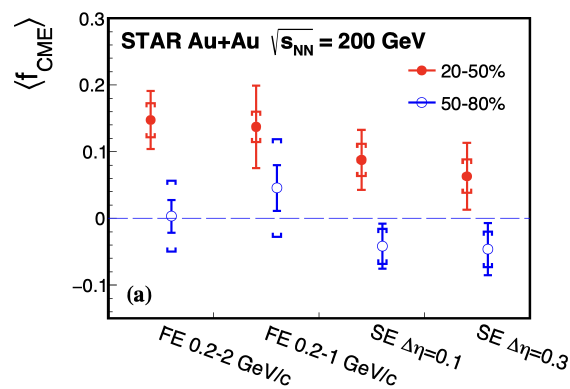
Figure 3. STAR results for the fraction of charge separation due to CME ( f CME utilizing the di ff erence in various signals with respect to forward and central reaction planes. Di ff erent columns represents variations in the methods, using full (FE) or sub-events (SE) for the analysis. The resulting signal is consistent with zero in peripheral collisions but 1-3 sigma away from zero in mid-central collisions. There are many important nuances here-see [21] for